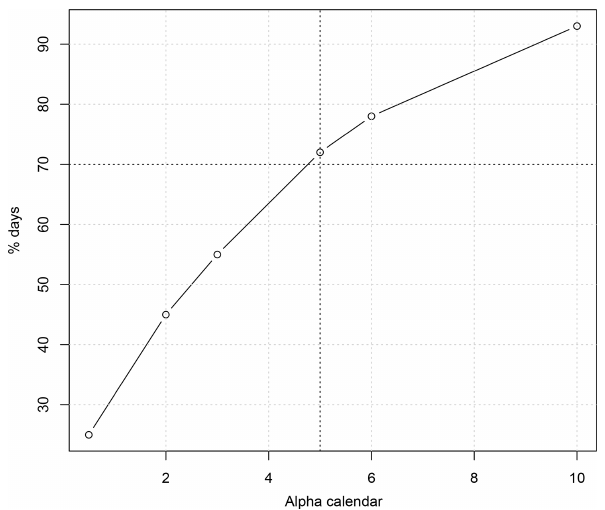
Figure 3. Percentage of dynamic simulations (from 100 simula- tions) of extreme summers for which the last day falls after 15 Au- gust, as a function of the parameter α cal , between 1 and 10. The vertical dashed line is for α cal = 5; the horizontal dashed line is for